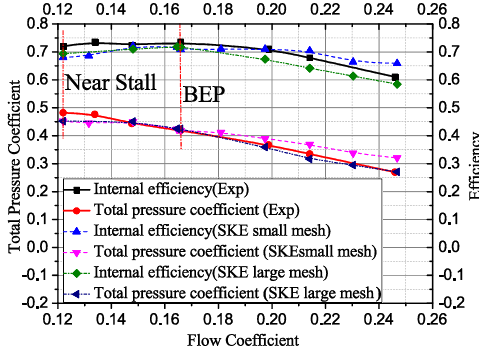
Figure 7. Comparison results between numerical and experimental curves.